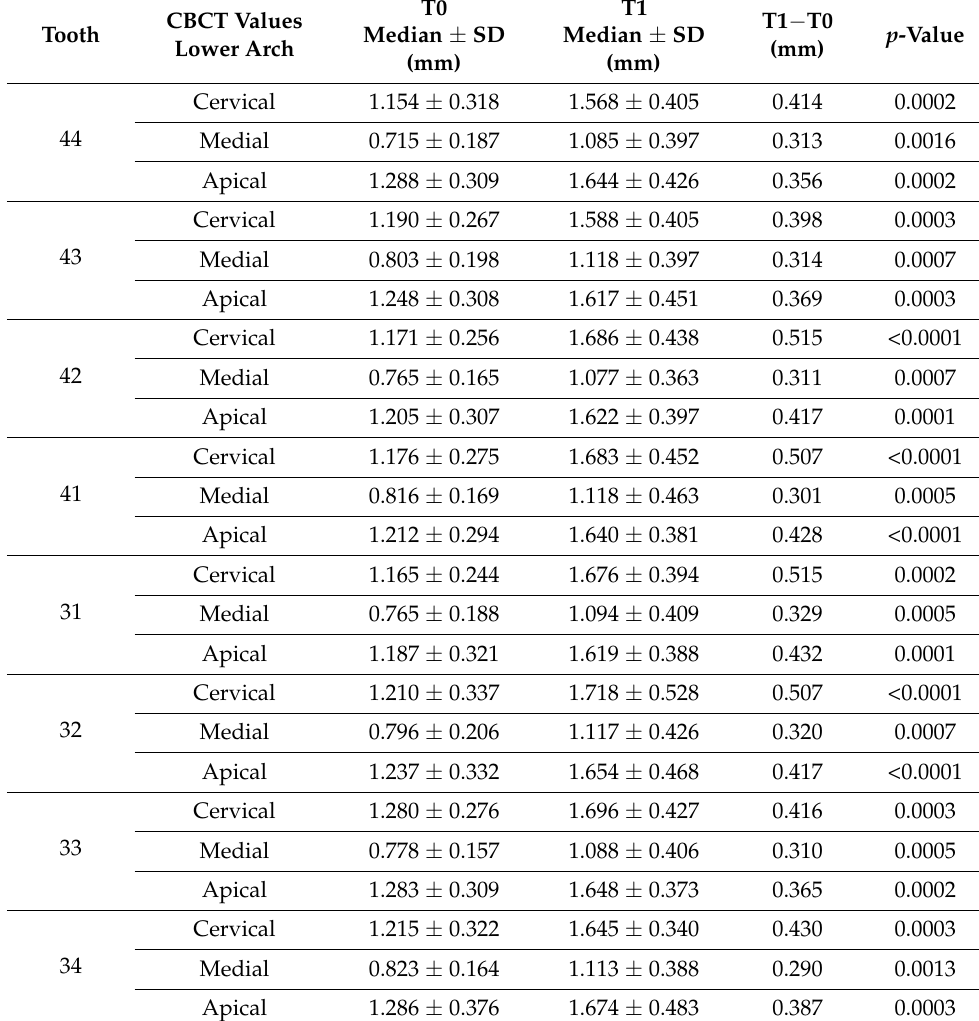
Table 4. Comparison of the level of buccal bone thickness at T0 and T1 for the mandibular teeth.